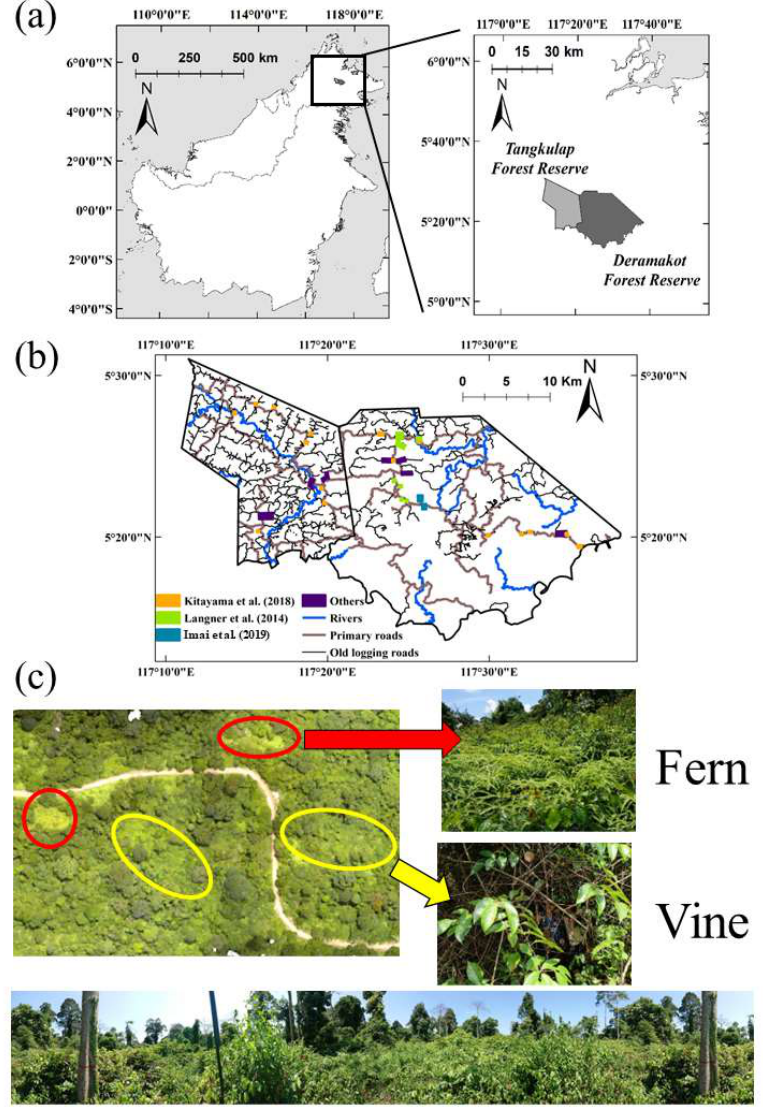
Figure 1. Description of the study sites: ( a ) Location of Deramakot and Tangkulap Forest Reserve; ( b ) The locations where we flew UAVs. The orange label represents 18 plots of Kitayama et al., the green label represents 11 plots of Langner et al., the blue label represents two plots of Imai et al., the purple label represents some of the abandoned logging roads, the pink line represents main roads, the black line represents old logging roads, and the blue line represents rivers. Main roads, old logging roads, and rivers were detected from the aerial imagery; ( c ) Pictures of fern thickets and vine-laden forests. Both the aerial imagery and panorama photo were taken in a plot of Kitayama et al., and represent the extent of the fern and/or vine thickets in the landscape. The red and yellow circles on the drone imagery show the locations of ferns and vines, respectively.